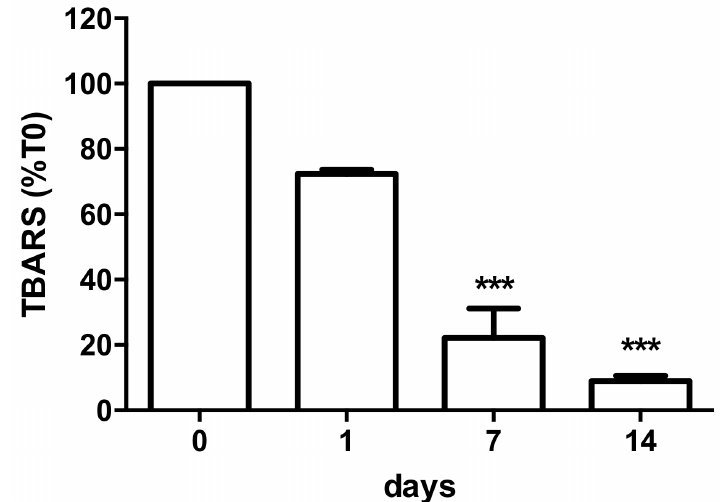
Figure 3. Cellular viability in the 3D-printed cell-laden multilayer. ( A ) Brightfield (left) and calcein- AM-loaded (right) cells at day 1 and day 21, respectively. ( B ) Cell viability measured at day 1, 7, 14 and 21 in 3D culture. N = 8 for each time-point. Significance set as ** p < 0.01, *** p < 0.001 for live cells (green line) and # p < 0.05 for death cells (red line) vs. control at time 0 (Day-0). Data are expressed as mean ± SD. Scale bars: 1 mm.